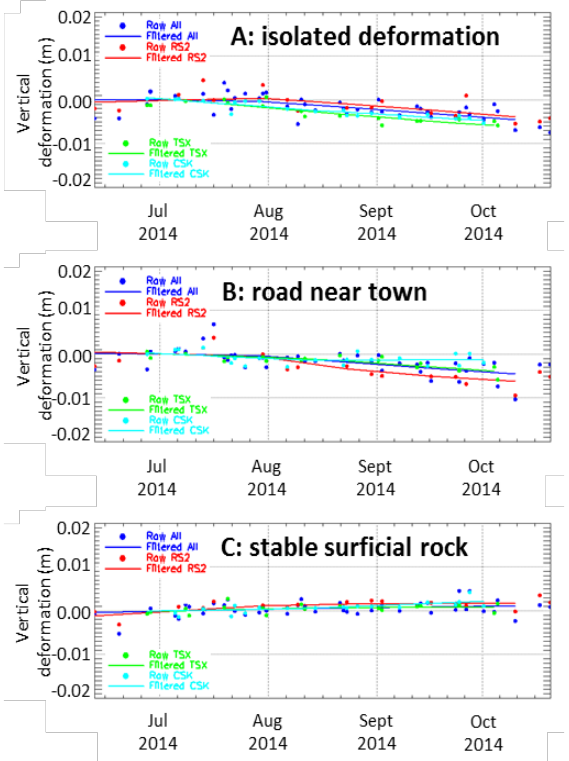
Figure 6. Example deformation time series for the four test cases. Spatial locations of A, B and C are shown on Figure